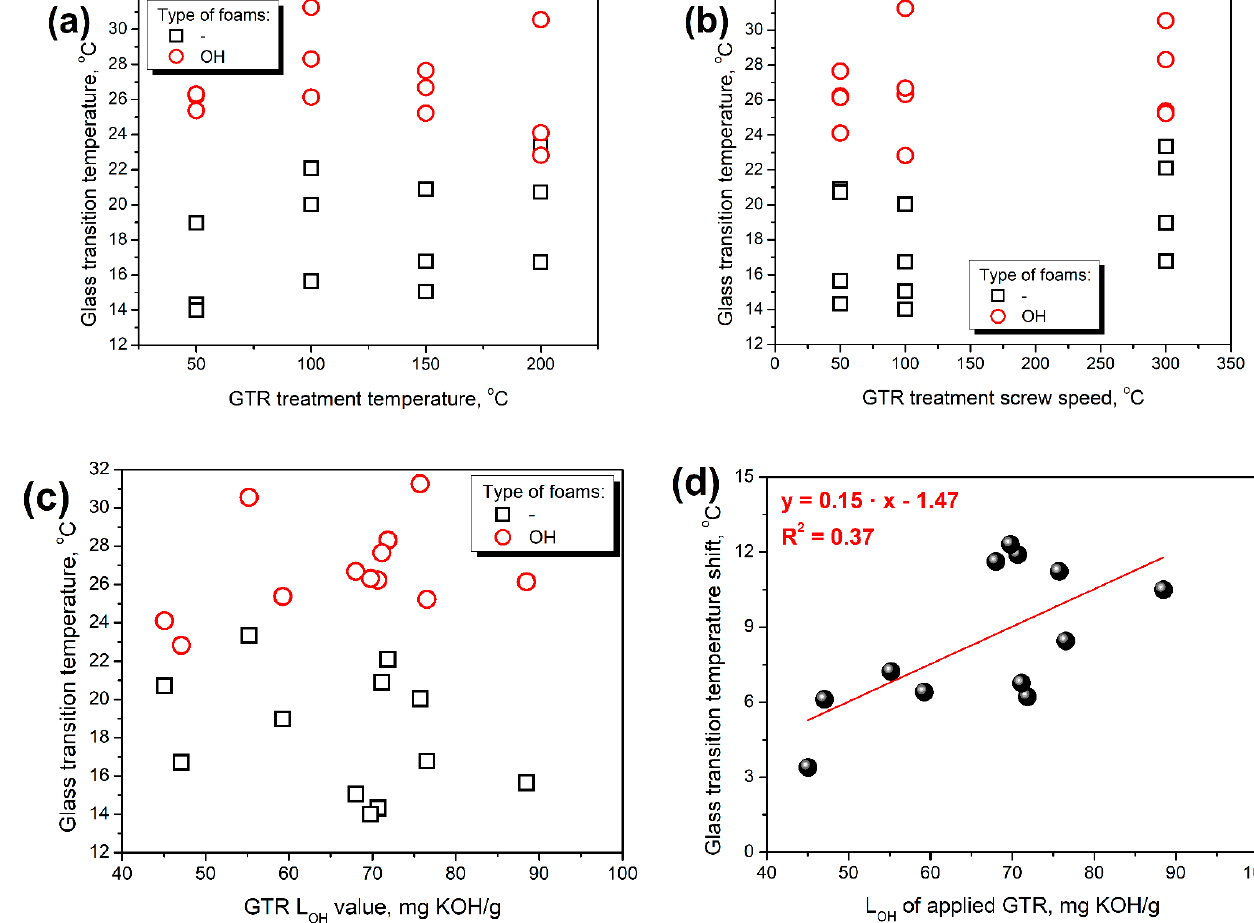
Figure 11. The impact of ( a ) GTR treatment temperature, ( b ) GTR treatment screw speed, and ( c ) GTR L OH value on the glass transition temperature of prepared PU/GTR composite foams, and ( d ) the relationship between L OH of applied GTR and glass transition temperature shift for PU/GTR composite foams after formulation